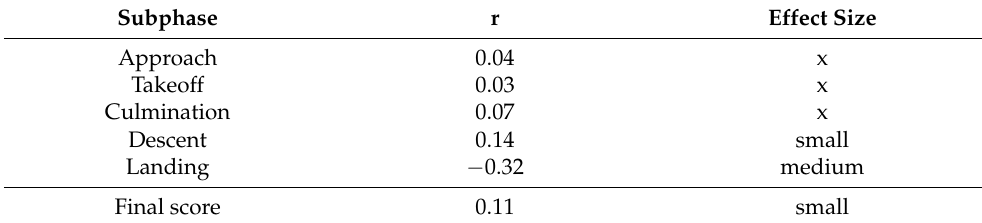
Figure 6. Comparison of the changes in the scores of the subphases between IP1 and IP2. Table 3. Differences expressed by the effect size.